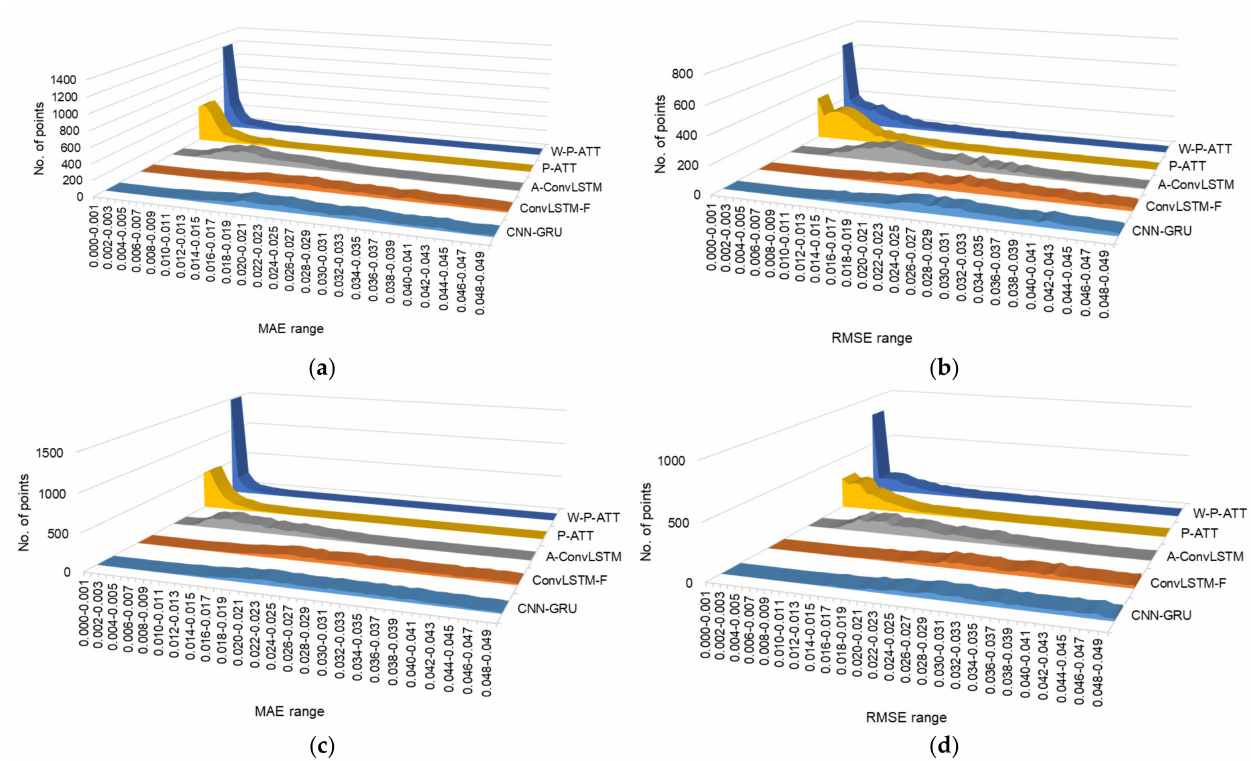
Figure 12. ( a , b ) The MAE and RMSE distributions for five models—u_current, ( c , d ) The MAE and RMSE distributions for five models—v_current. The subfigure ( a ) is MAE distribution for u_current and the subfigure ( b ) is RMSE distribution for u_current. The subfigure ( c ) is MAE distribution for v_current and the subfigure ( d ) is RMSE distribution for